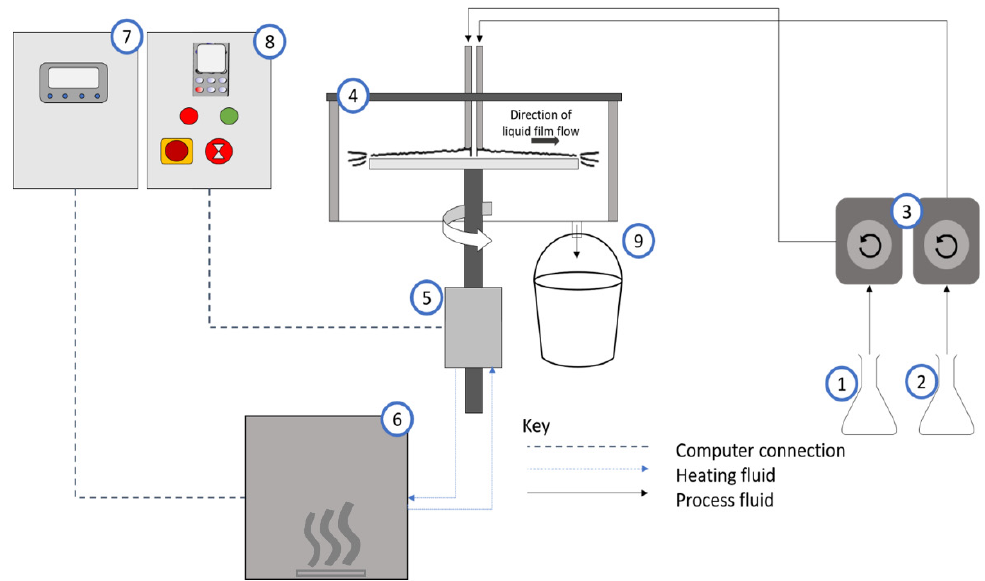
Figure 1. Schematic of experimental set-up for spinning disc reactor (SDR). ( 1 ) solute / solvent feed, ( 2 ) antisolvent feed, ( 3 ) peristaltic pumps, ( 4 ) SDR, ( 5 ) motor, ( 6 ) temperature-controlled water tank, ( 7 ) temperature control unit, ( 8 ) SDR rotational control unit, and ( 9 ) product outlet and receiver. Reproduced from [39], MDPI, 2020.